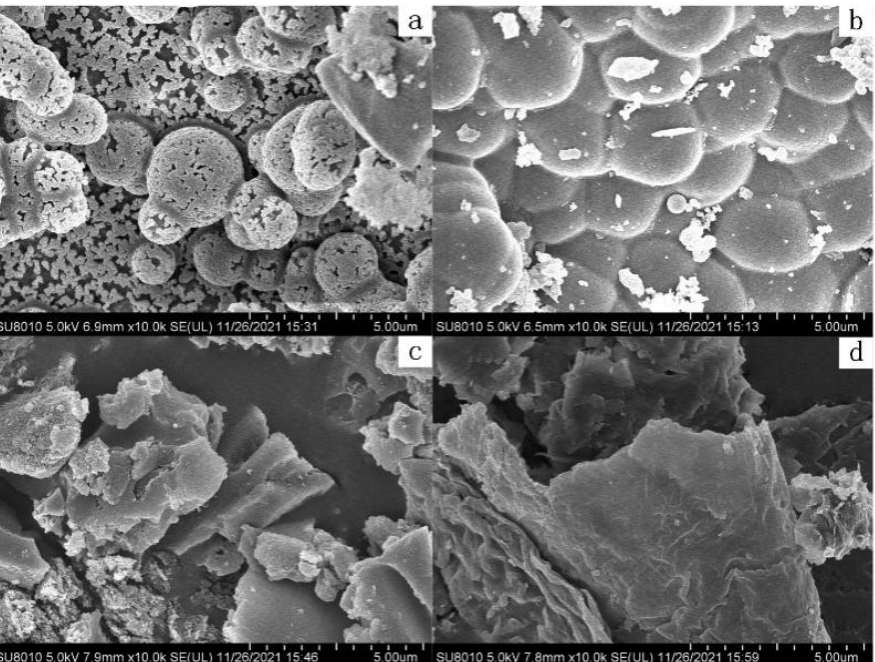
Figure 1. SEM images of: ( a ) MCM-48-SH, ( b ) MCM-48, ( c ) CAC, and ( d ) BTT. SEM, scanning electron microscope; CAC, coconut shell activated carbon; BTT,